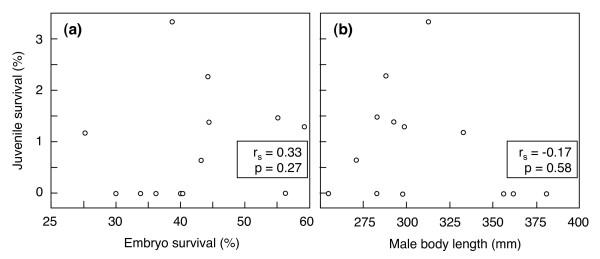
Juvenile survival in the field (means ± SE) versus embryo survival and male body length. Juvenile survival during 20 months as determined in the second experiment (total number of juveniles/total number of released hatchlings). The inserts give the Spearman rank order coefficients rs and the two-tailed p-values.